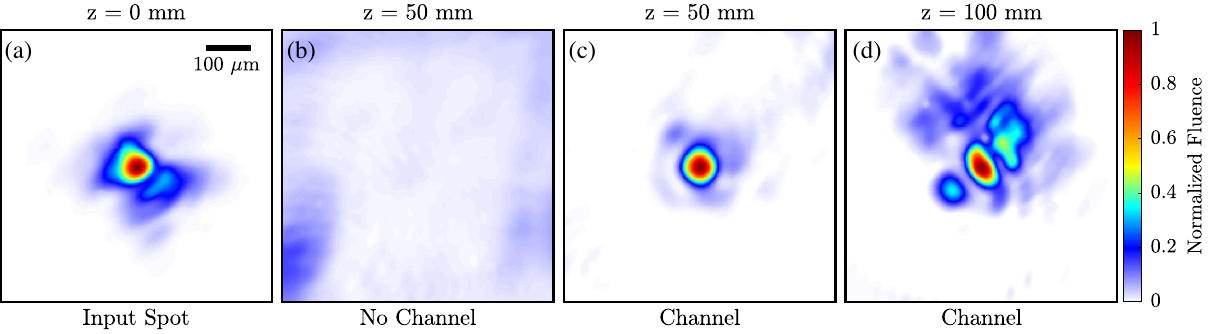
FIG. 3. Measured transverse fluence profiles of the guided beam at: (a) focus, in vacuum; (b) z ¼ 50 mm, in vacuum; (c) z ¼ 50 mm, for P ¼ 68 mbar and τ ¼ 3 . 0 ns; (d) z ¼ 100 mm, for P ¼ 26 mbar and τ ¼ 2 . 7 ns. The transverse scale is the same for all plots, as indicated by the scale bar shown in (a). For plots (a), (c), and (d) the fluence is normalized to the peak value in that plot; the fluence scale for (b) is the same as in (a). Compared to (a), the fluence scales of (c) and (d) were increased by factors of approximately 4 and 7 respectively.